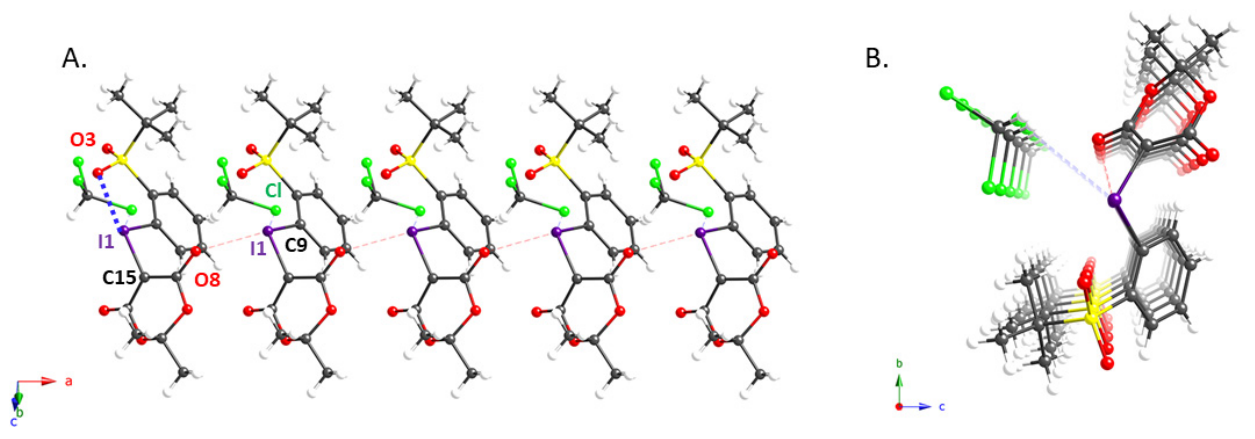
Figure 2. Crystal structure of iodonium ylide 2g : ( A ) sideview of 2g ; ( B ) columnar structure formed by one stacked column of 2g and residual chloroform molecules. Table 2. Crystallographic parameters of the intra- and intermolecular XB interactions in the crystals of iodonium ylides 2e and 2g .